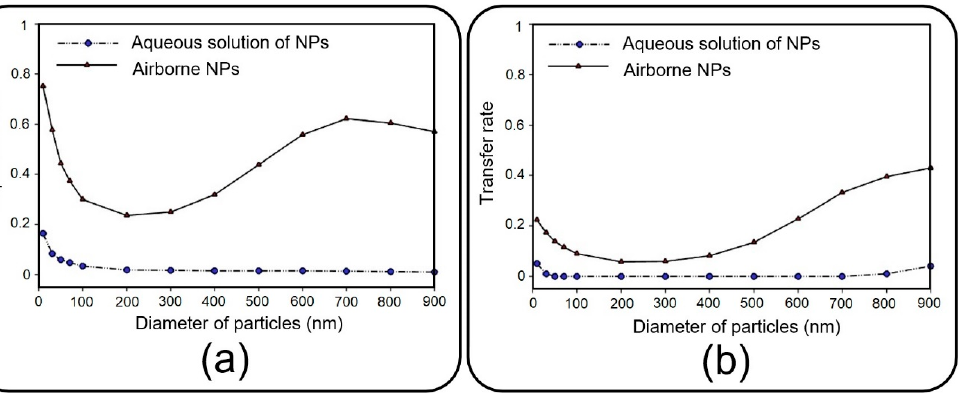
Figure 7. ( a ) Deposition rate and ( b ) transfer rate of the media- and air-induced NPs in the top channel of the lung-on-a-chip device when the fluid velocity is 0.3 mm/s, and both pore diameter and pore-to-pore distance are 10 µ m.